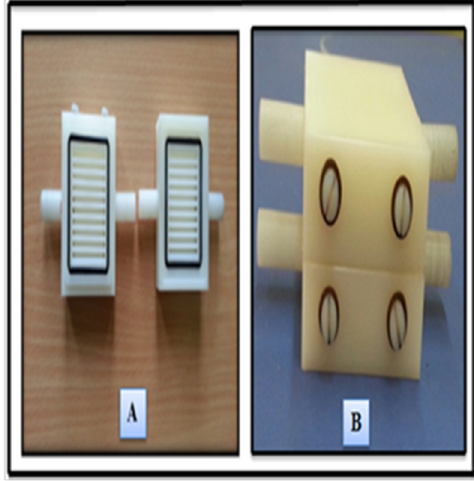
Fig. 2. Membrane module. (A) Inside the module, (B) Outside the